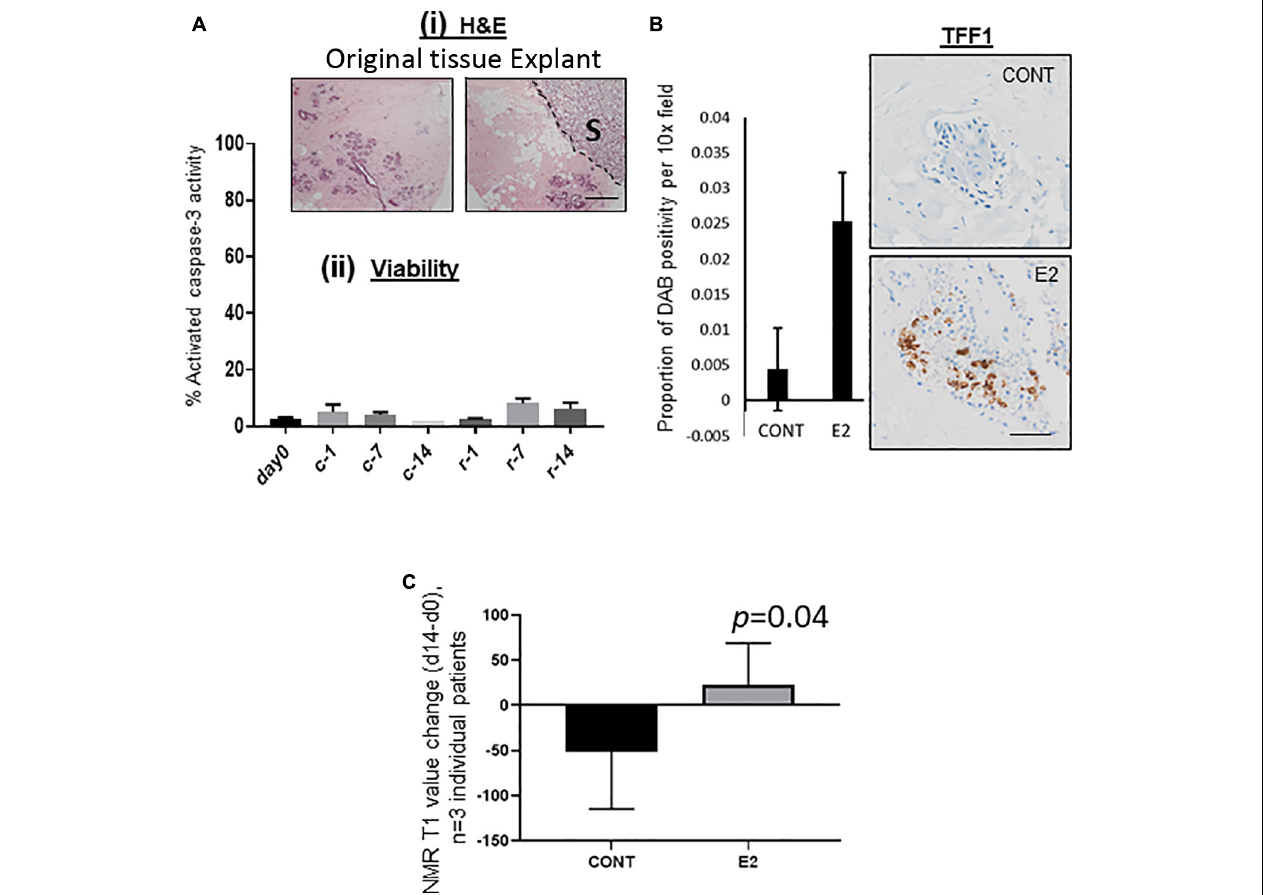
FIGURE 2 | (A) (i) Morphological comparison of original tissue at t = 0 and following 14 days as explant culture. S denotes position of the sponge, delineated from the explant tissue by a dotted line. (ii) Viability of explanted tissue up to 14 days as assessed by% activated caspase 3 activity as measured by IHC. C, clear media (Phenol-red free); r, red media (Phenol-red containing). (B) 1nM Estradiol treatment of PDEs led to a clear upregulation of the E2-signaling pathway protein TFF-1, images and quantification are typical representative data of 3 individual patients. (C) Mammographic density change (d14–d0) in E2 treated mammary tissue explants as measured by the change in NMR T1 values. For part (C) only, Student’s paired T -test was used to determine significance, with p -values displayed on graph, n = 3 individual patient tissue tested. For all images shown, 10x magnification was used, scale bar = 50 µ